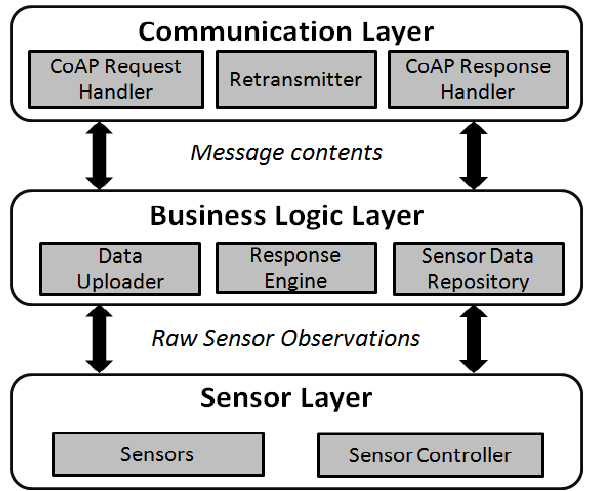
Figure 7. The device architecture supporting the CoAP